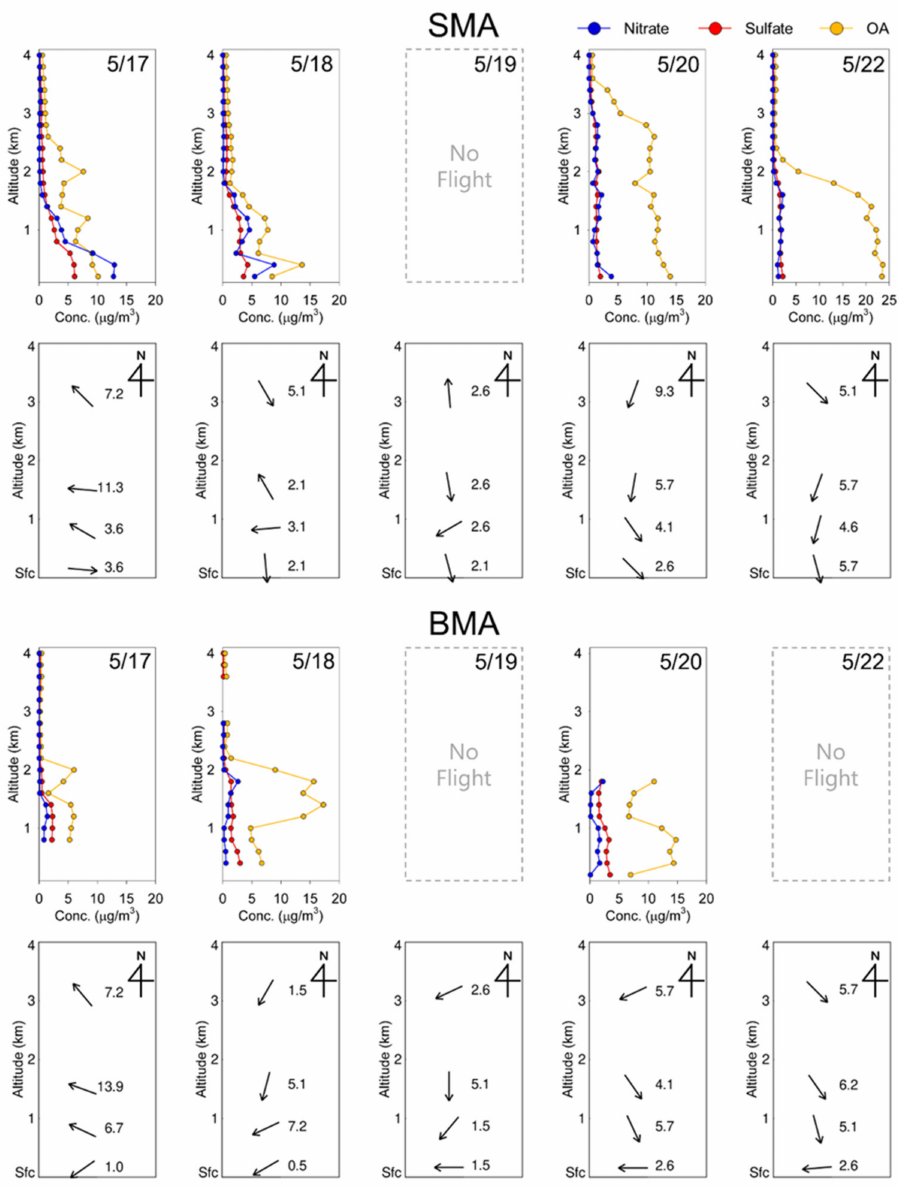
Figure 6. Aircraft-measured vertical distributions of chemical components during KORUS-AQ and observed wind profiles for the stagnant period (18–23